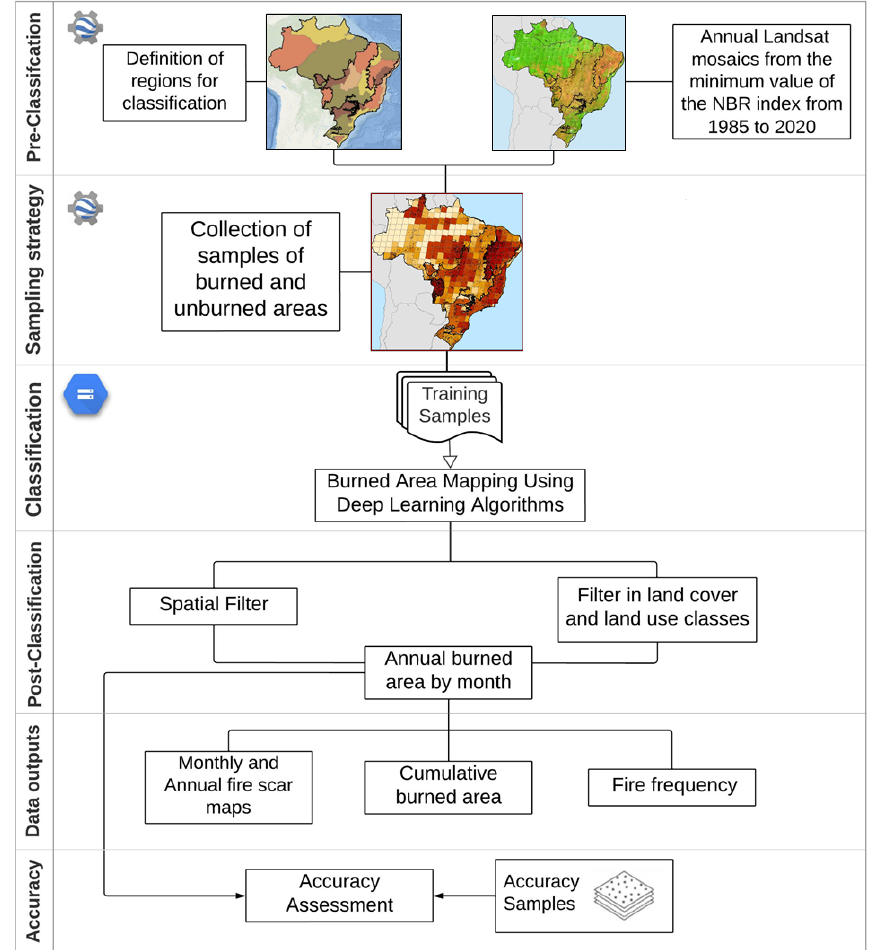
Figure 2. Overview of the method for classifying burned areas in Brazil.